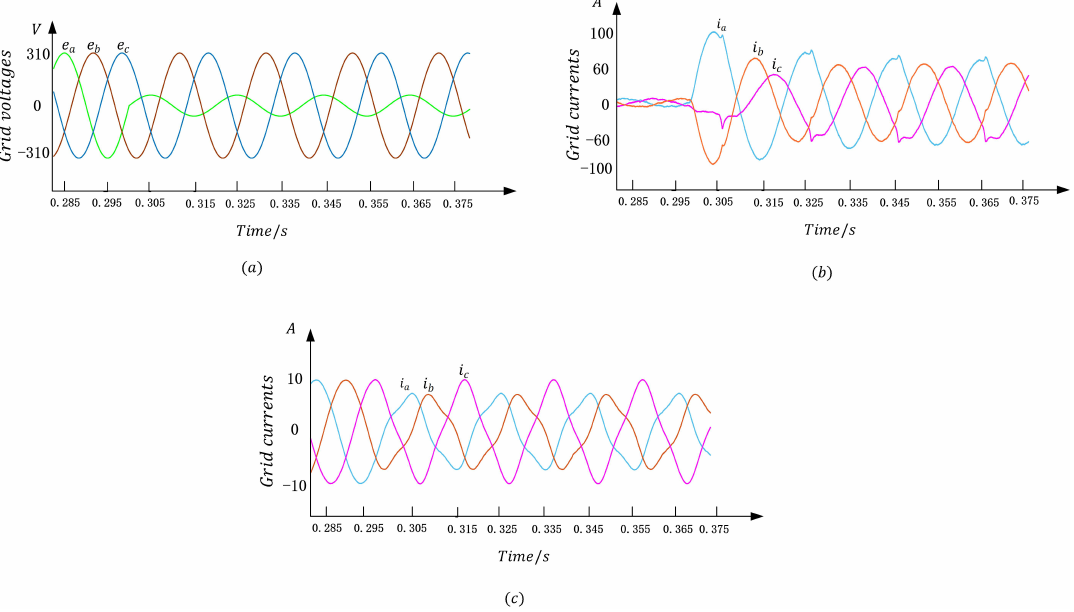
Figure 5. Grid voltages ( a ). Grid currents of PI closed-loop control ( b ). Grid currents of ADP closed-loop control ( c